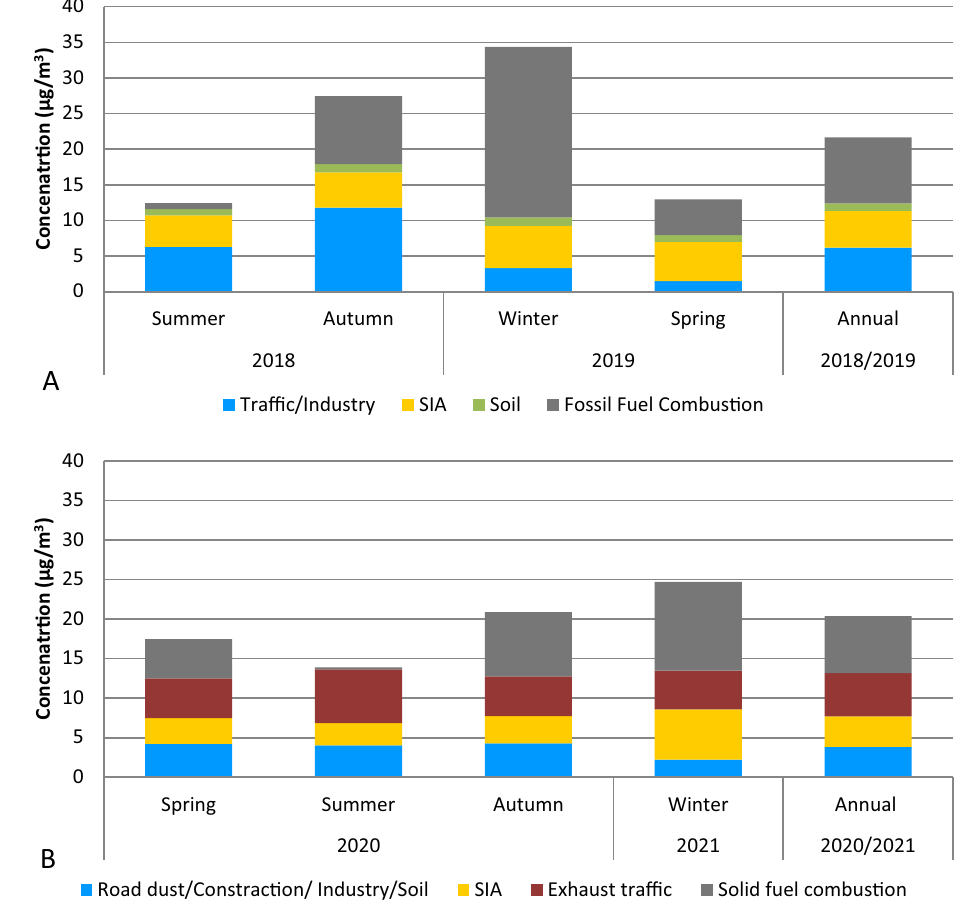
Figure 7. The seasonal and annual contribution of sources to PM 2.5 mass in μg/m 3 . ( A ) For the year 2018/2019 and ( B ) for the year